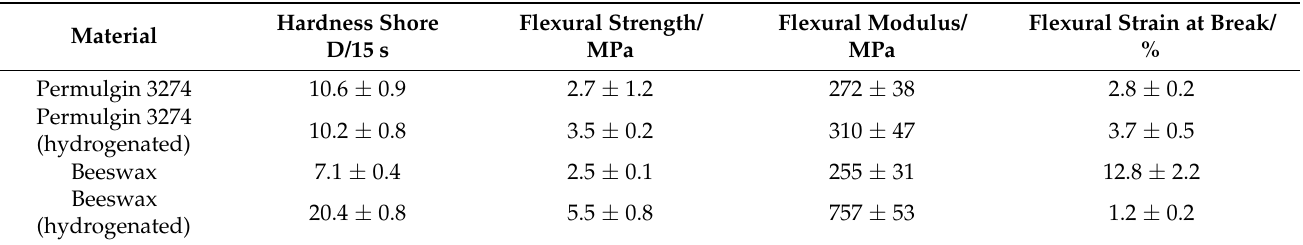
Figure 7. Thermal volume expansion of beeswax and Permulgin 3274. Table 2. Comparison of mechanical properties of Permulgin 3274, beeswax and their hydrogenated derivatives. The data are expressed as mean ± standard deviation. The reference data for beeswax and hydrogenated beeswax were taken from [2].